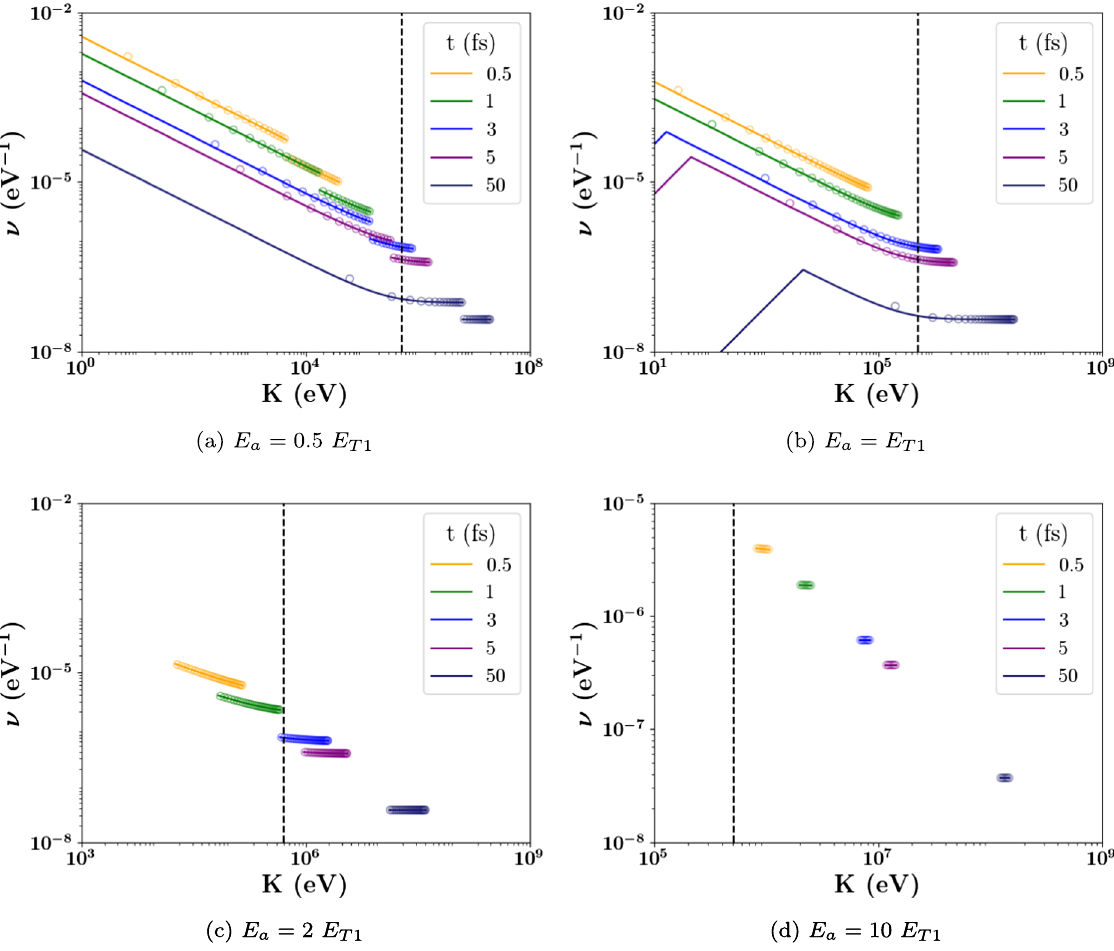
FIG. 13. Theoretical predictions (solid line) and M -shell simulations (hollow dots) of the planar symmetric energy density at 4 different times with different applied extraction fields: (a) E Q tot ; 1 E and Q is the total surface-charge density. The results are independent of the initial profile and were obtained both from 2 ϵ 0 T 1 ¼ tot ; 1 analyzing the simulations described in Figs. 11 and 12. Notice the log-log plot and the discreet jump in density seen when E in (a), which coincidentally overlaps some of the t ¼ 0 . 5 fs and t ¼ 1 fs distributions. The energy where this jump occurs corresponds to the maximum energy of the particles moving in the − z -direction. At and above E no particles moving in the − z -direction. Also note that the energy distribution width appears to be constant once it is in the relativistic regime — this is an optical illusion of the logarithmic